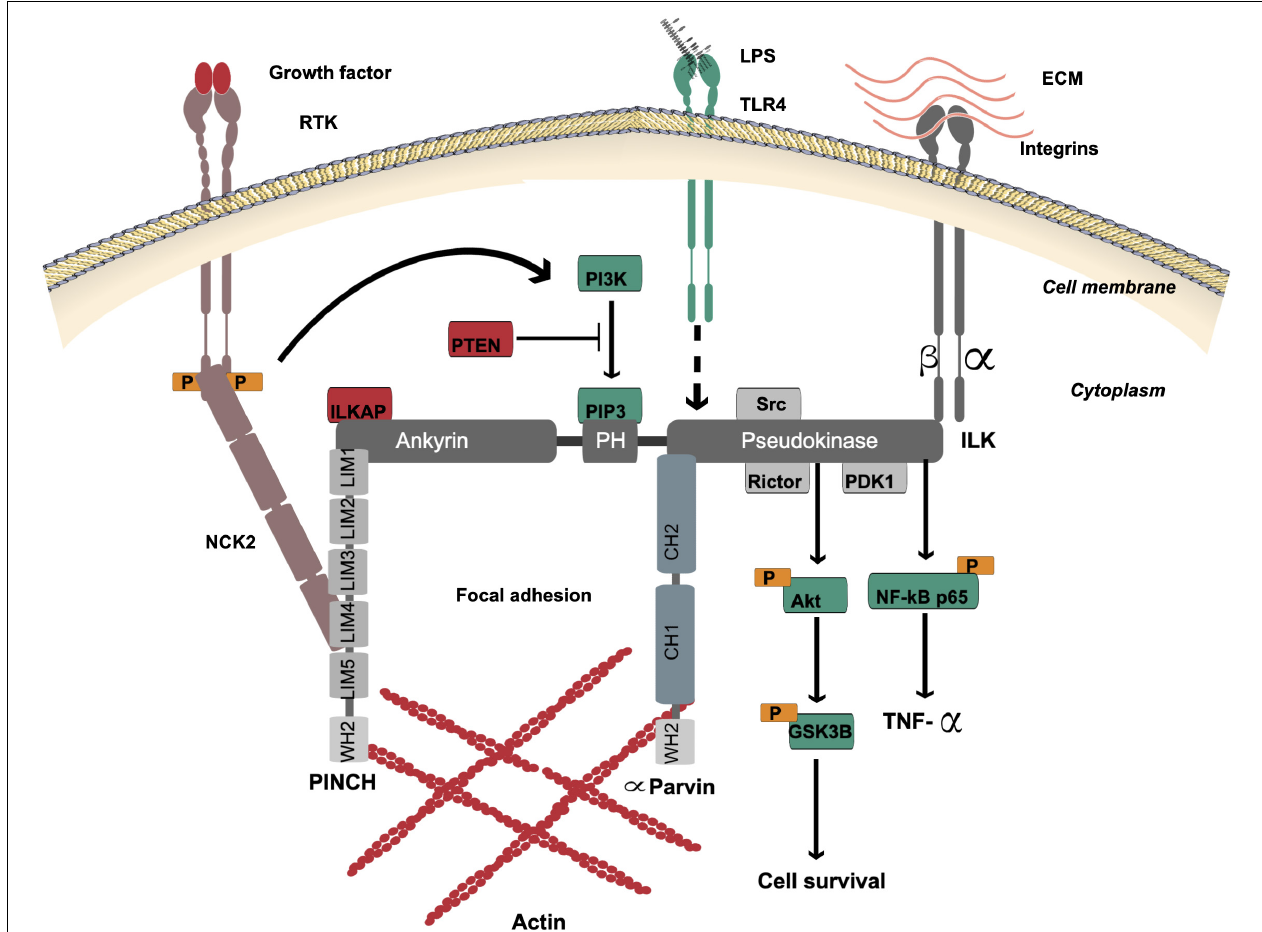
FIGURE 1 | ILK structure and multi-protein binding. The localization of ILK is to focal adhesions. ILK contains three distinct domains: four repeats of amino-terminal ankyrin, a central PH-like domain and a carboxy-terminal pseudokinase catalytic domain. The ankyrin repeat domain binds the negative regulator of ILK, ILKAP, and also binds PINCH, which interacts with NCK2 for connection of ILK with growth factor receptors (RTK). The PH-like domain is in the center of ILK protein that binds PIP3, which is essential for activation of ILK via PI3K. PIP3 is dephosphorylated by tumor suppressor PTEN to negatively regulate the ILK activation. The ILK pseudokinase domain interacts with cytoplasmic domains of β 1 and β 3-integrin subunits and different actin-binding adaptor proteins such as α -Parvin. The interaction of ILK with PINCH and α -Parvin mediates the communication between the ECM and actin. The main ILK-binding proteins, which are involved in cell signaling via the pseudokinase domain, are PDK1, Rictor and Src. The ILK pseudokinase domain also interacts with and regulates the Akt-GSK3 β signaling pathway. ILK mediates activation of the TLR4/NF- κ B/TNF- α signaling pathway by lipopolysaccharides (LPS). The dotted line indicates the proposed mechanism of downstream